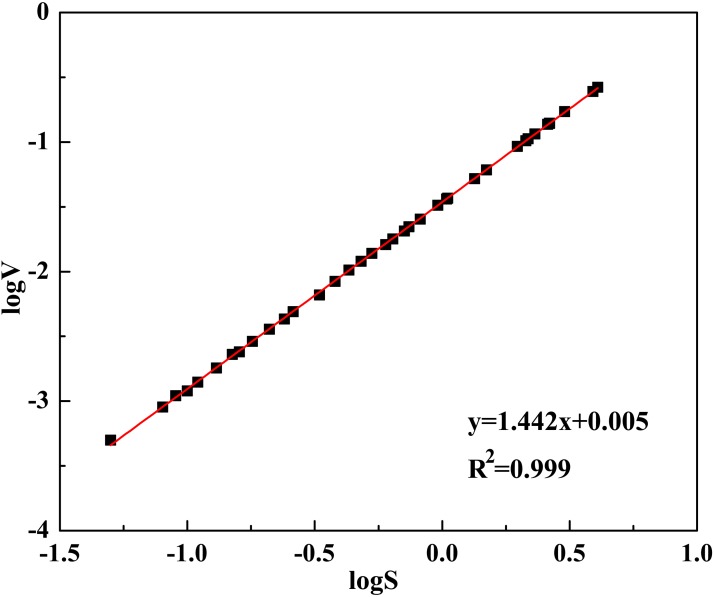
logVvs. logS for the 44 glaciers in EAMs, northwest China.